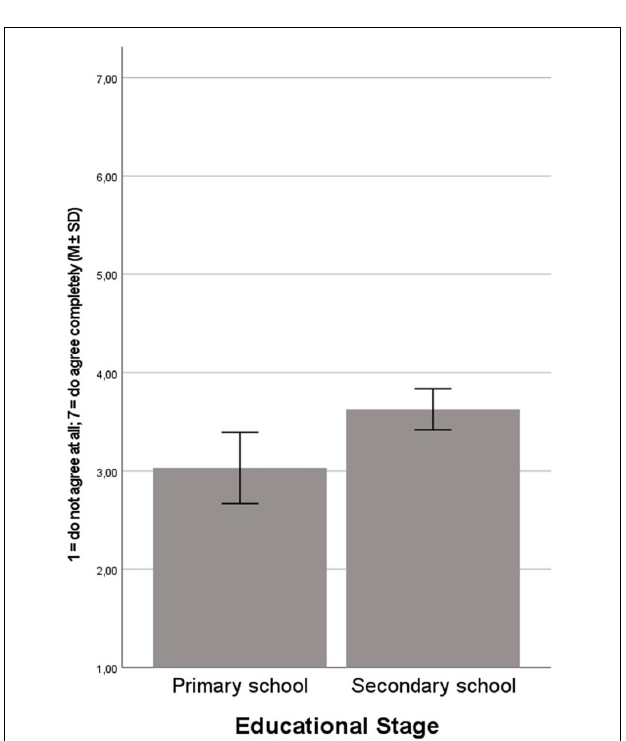
four items are large. However, although all effect sizes are large,